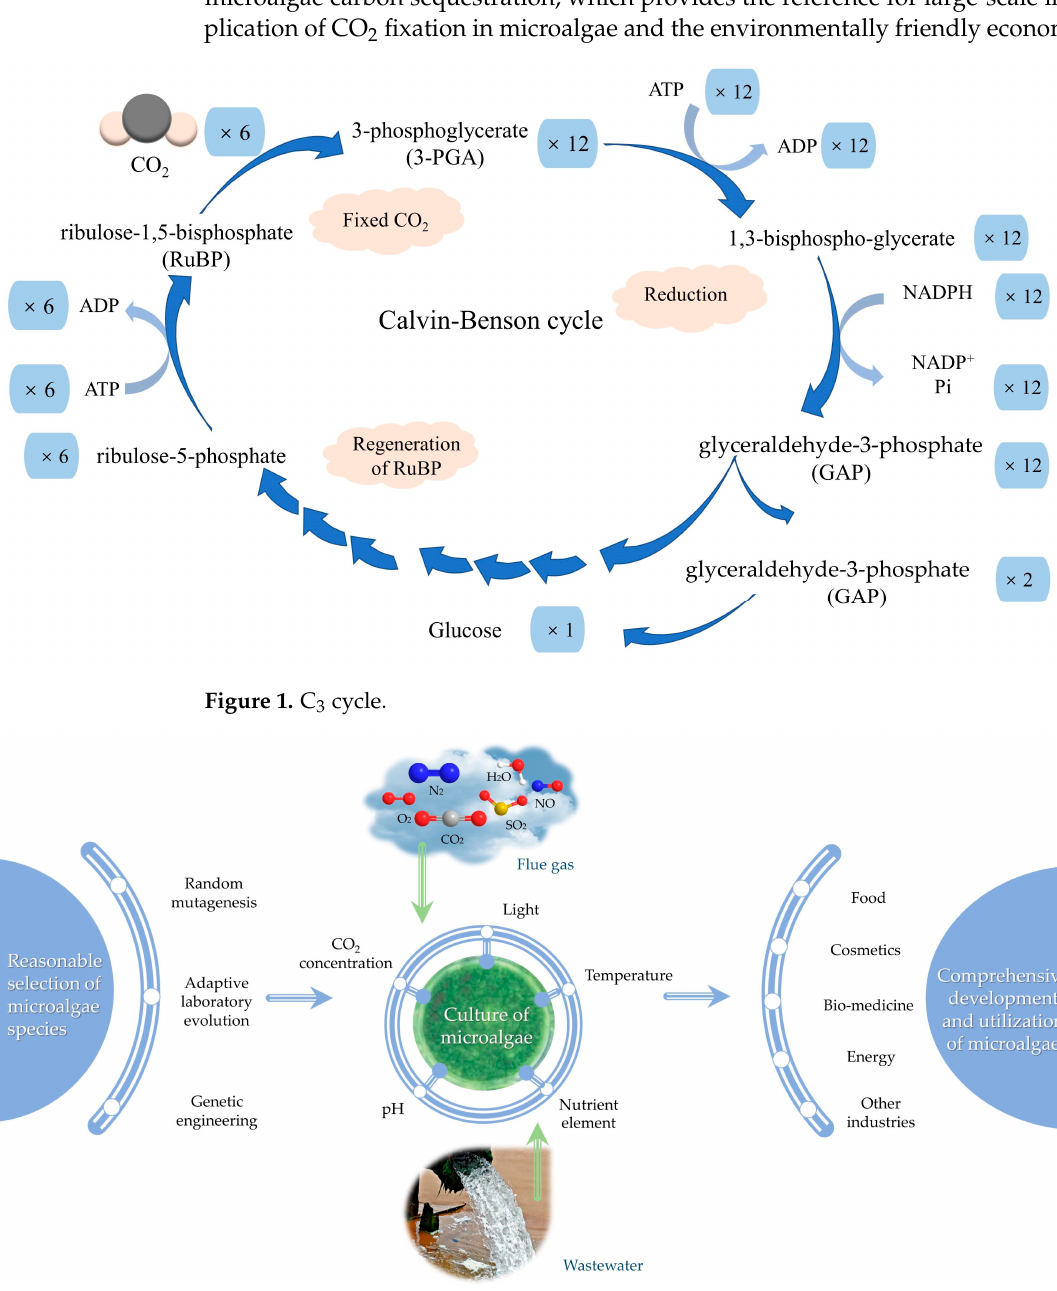
Figure 1. C 3 cycle.